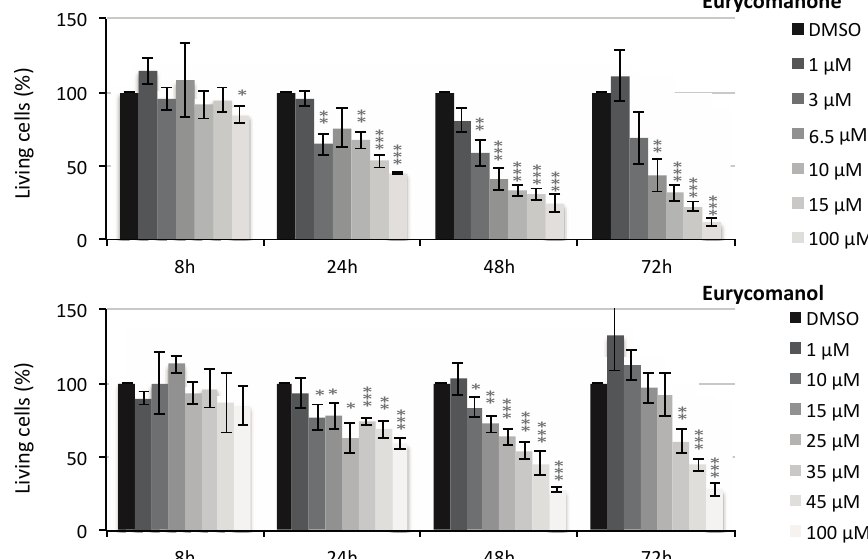
Figure 2. The effect of eurycomanone and eurycomanol on K562 ( A ) and Jurkat ( B ) cell viability. Cell viability was assessed by the trypan blue exclusion test. DMSO corresponds to solvent-treated control. Each value is the mean ± SEM of three independent